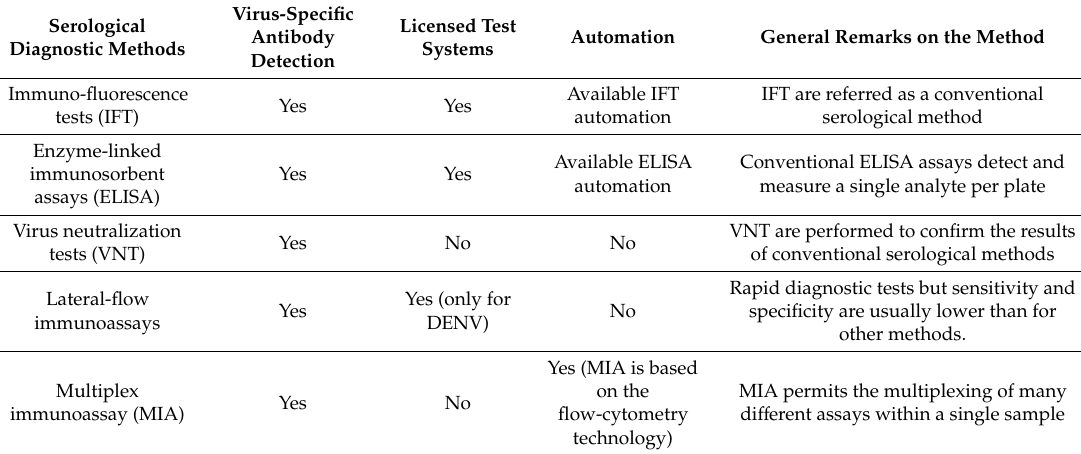
Table 2. Serological methods for detecting flavivirus-specific